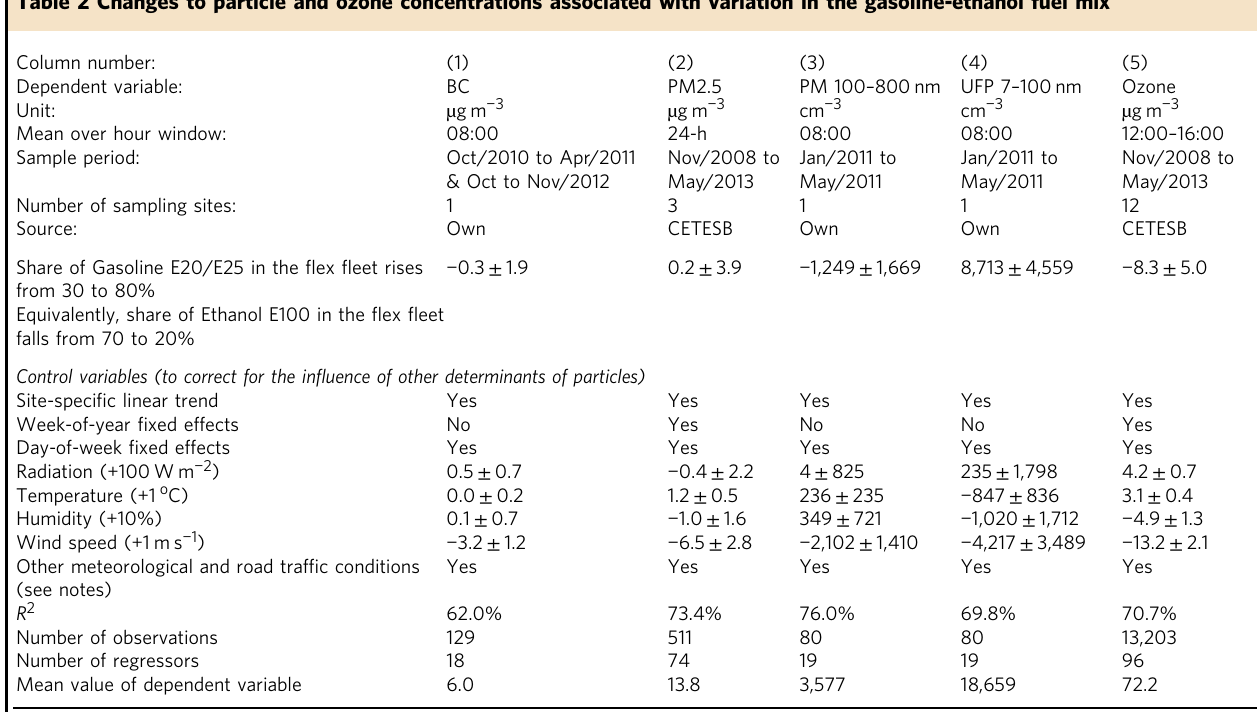
(OLS)estimates, withstandarderrorscalculatedbybootstrapping (200sampleseach):(i)the consumer-levelfuelchoicedata,toaccountforsamplingvariationin thepredictedgasolineshareina fi rst- step consumer demand model, and (ii) the pollutant-meterology-traf fi c data in the second-step particle regression, clustering by date